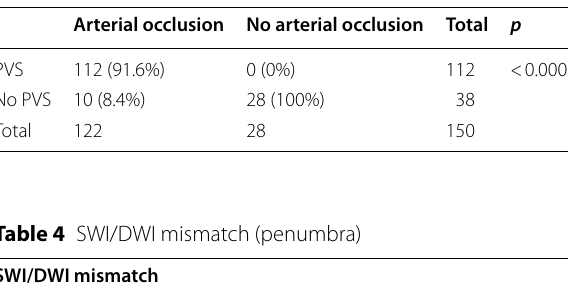
Table 3 Prominent vessel sign and arterial occlusions